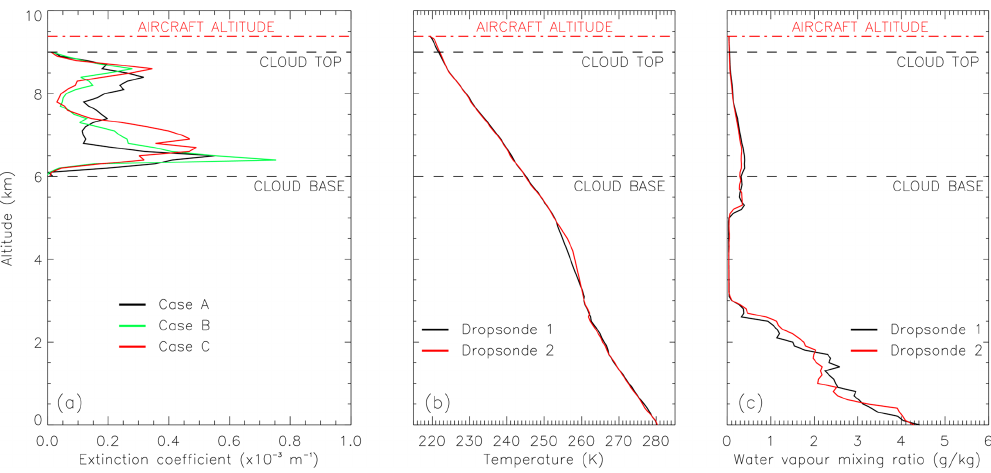
Figure 3. (a) Lidar extinction coefficient profiles for cases A–C. (b) Dropsonde temperature profiles from the two dropsondes deployed during SLR 1. (c) As in panel (b) but for the water vapour mixing ratio profiles. The altitude of the aircraft and the upper and lower boundaries of the cirrus cloud layer are indicated by the black dashed lines. Table 1. Summary of the three cases (A, B and C) identified for use in this study, detailing the time of TAFTS, ARIES and lidar observations, along with the key variables from the onboard aircraft instrumentation obtained at the time of the TAFTS observations. Note that the TAFTS observation (obs.) times represent the UTC time (hh:mm:ss) and the equivalent seconds since midnight (sSM) times. Also, note that there are two ARIES spectra (forward and reverse scan directions of the interferometer) associated with each ARIES observation time. The lidar time indicates the start of a 10s period over which the data are